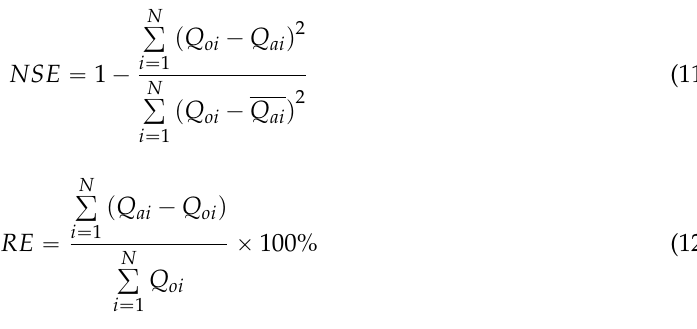
Figure 3. Variations in annual runoff and its five-year moving average process at the Daning station for 1955–2008. Figure 3 shows that, first, recorded runoff presented high variability, ranging from 7.1 mm in 1999 to 107.1 mm in 1958. Most of the high runoff years occurred in the 1950s and 1960s. Observed runoff has been continuously and unprecedentedly low since 2000. Second, the runoff series exhibited a significant decreasing trend, with a linear decline rate of 0.854 mm/year. Third, the runoff series for 1955–2008 could be visibly divided into three phases: a higher flow period in 1955– 1965, a medium flow period in 1966–1980, and low flow period in 1981–2008. An abrupt change point in the runoff series induced by human activity likely occurred in 1965, going by a rough visual calculation.